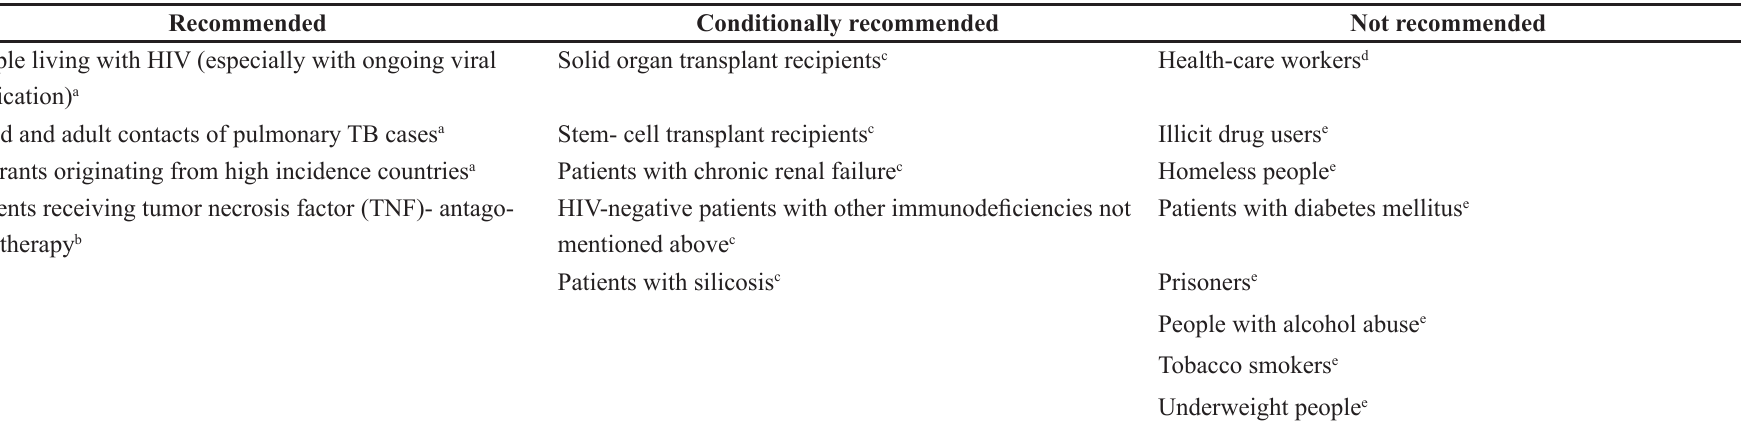
Table 4. Recommendations for the use of IGRA-testing* and preventive chemotherapy against active tuberculosis in low-incidence countries according to the number needed to treat to prevent one case of